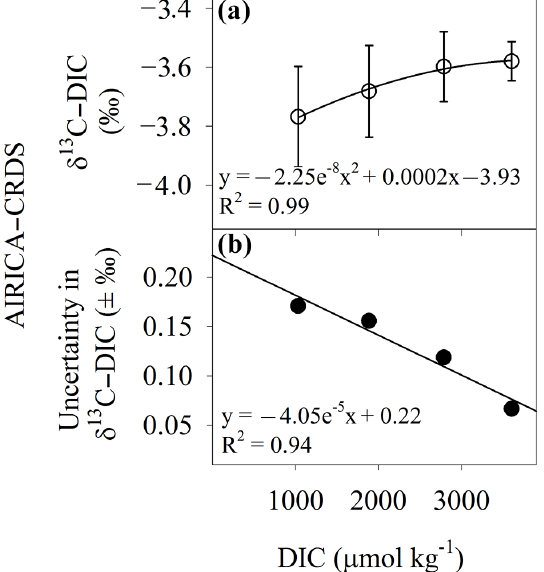
Figure 2. (a) Concentration effect on δ 13 C-DIC data produced by the AIRICA–CRDS. (b) Uncertainty in δ 13 C-DIC versus DIC con- centration.